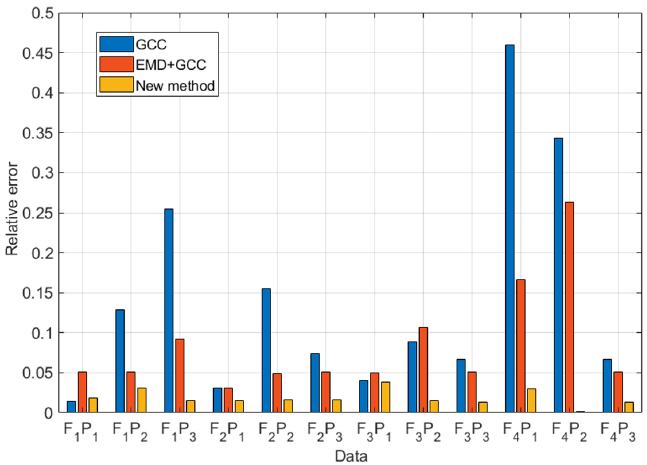
Figure 14. Relative error of the tested methods.